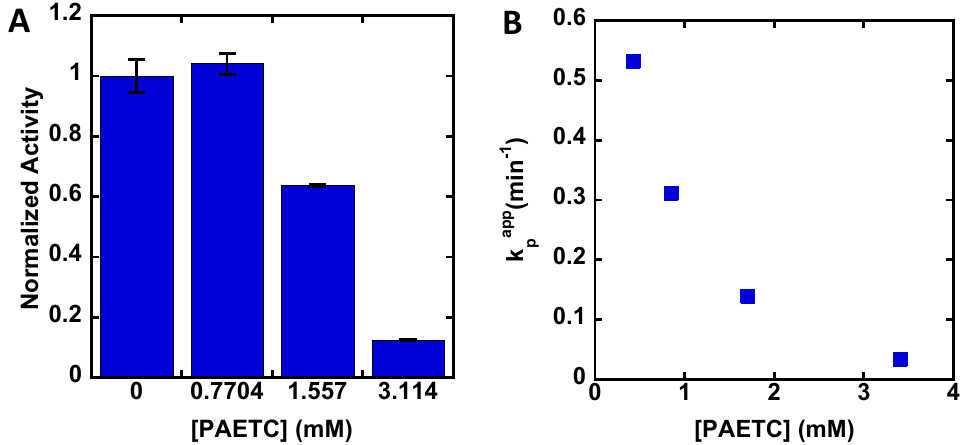
Figure 6. ( A ) Relative rate of enzymatic activity, as a function of PAETC loading, measured by the reaction of aminoantipyrine and phenol, normalized to activity at no PAETC loading; ( B ) Apparent polymerization rate (k papp ) under the conditions: [DMAm] 0 :[PAETC] 0 :[ACAC] 0 :[H 2 O 2 ] 0 = 100: X :9.7:1.7, [DMAm] = 170 mM, [HRP] = 0.71 mg/mL in 4.2 mL of pH = 5.5, 20 mM acetate buffer at 25 °C.